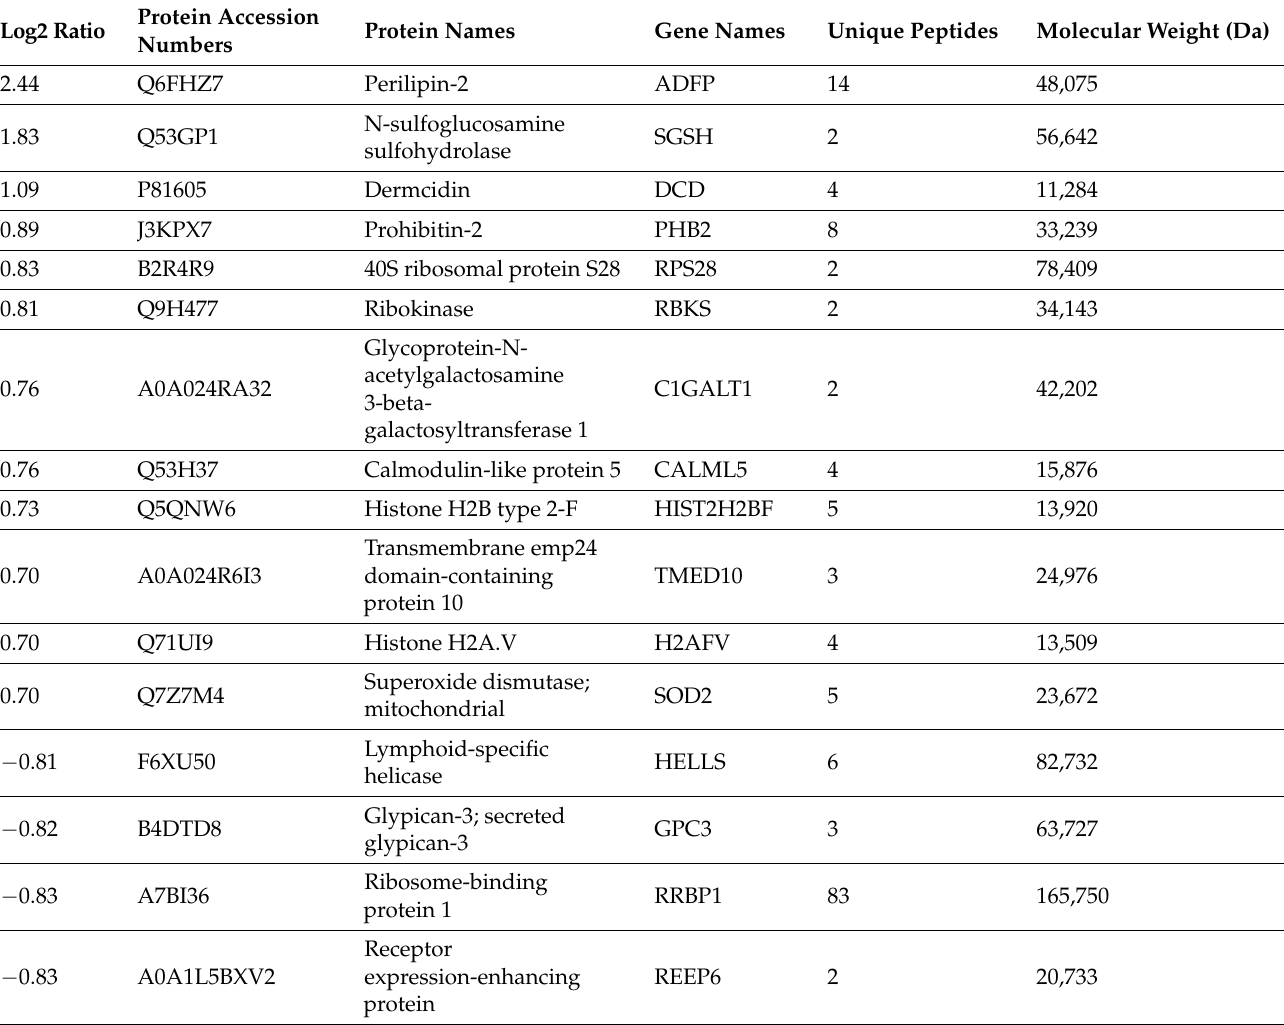
Table 1. Quantified proteins in NAFLD versus control samples obtained via three